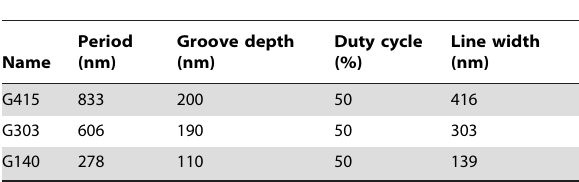
Table 1. Nomenclature for PMMA films with nanotopographic